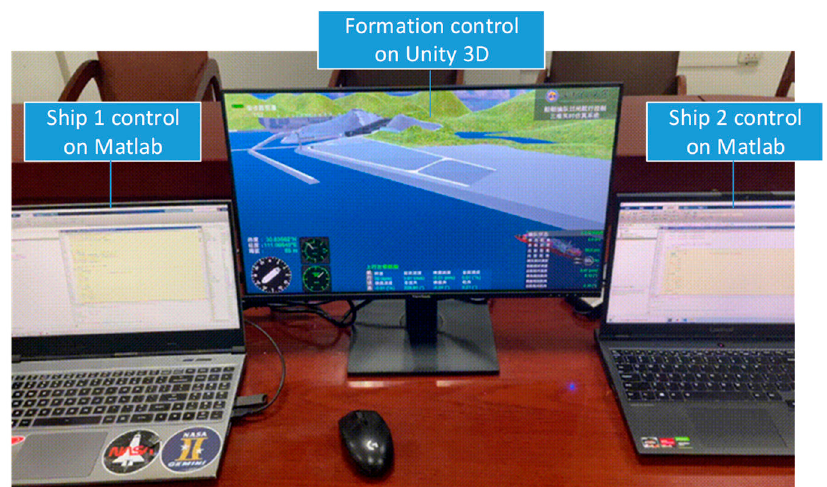
Figure 12. Vessel formation simulation system for lock waters.